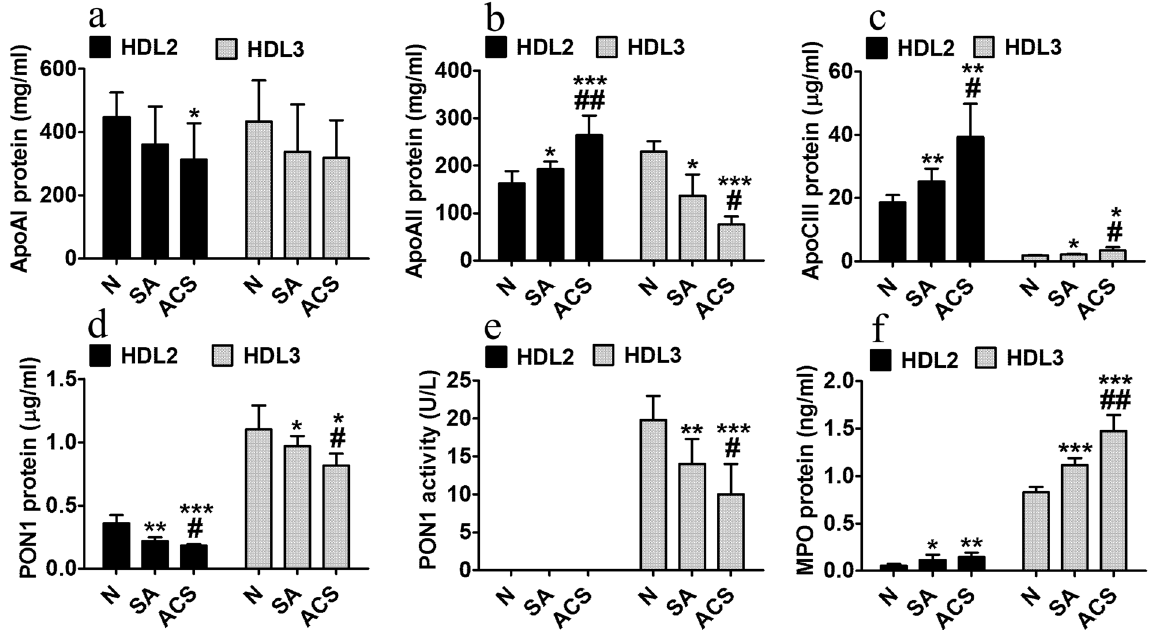
Figure 3. Characterization of HDL 2 and HDL 3 subfractions isolated by density gradient ultracentrifugation from seven independent pools of sera collected from healthy subjects (N), stable angina patients (SA) and acute coronary syndrome (ACS) patients. Levels of apolipoprotein AI (ApoAI) ( a ), ApoAII ( b ), ApoCIII ( c ), paraoxonase 1 (PON1) protein ( d ) and paraoxonase activity ( e ), and myeloperoxidase (MPO) protein ( f ). Data are expressed as means ± SD and analyzed with Independent Student’s T-test; * p < 0.05, ** p <